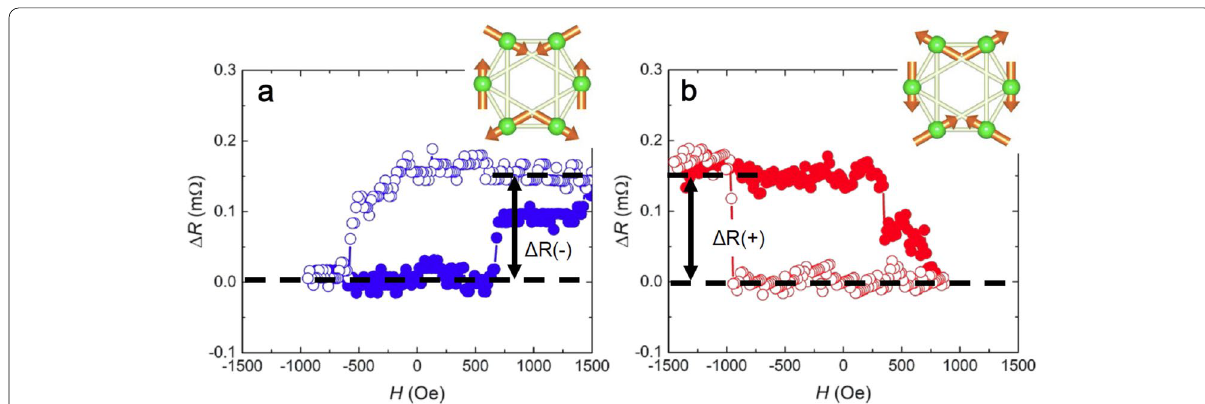
Fig. 8 Spin accumulation signal appearing at the interface between a Weyl antiferromagnet Mn 3 Sn and a ferromagnet [41]. The hysteresis of the resistance change Δ R caused by the magnetic field sweep indicates the presence of accumulated spins on the surface of Mn 3 Sn. The sign of the hysteresis observed in the resistance change Δ R varies with the reversal ( a , b ) of the magnetic octupole polarization ( T xγ , upper right inset, corresponding to Fig. 1b). This corresponds to a reversal in the sign of the spin accumulation signal. The normal spin Hall effect is independent of the direction of the magnetic moment and magnetization. These experimental results reveal the existence of a new (magnetic) spin Hall effect that depends on the polarization direction of the negligible octupole